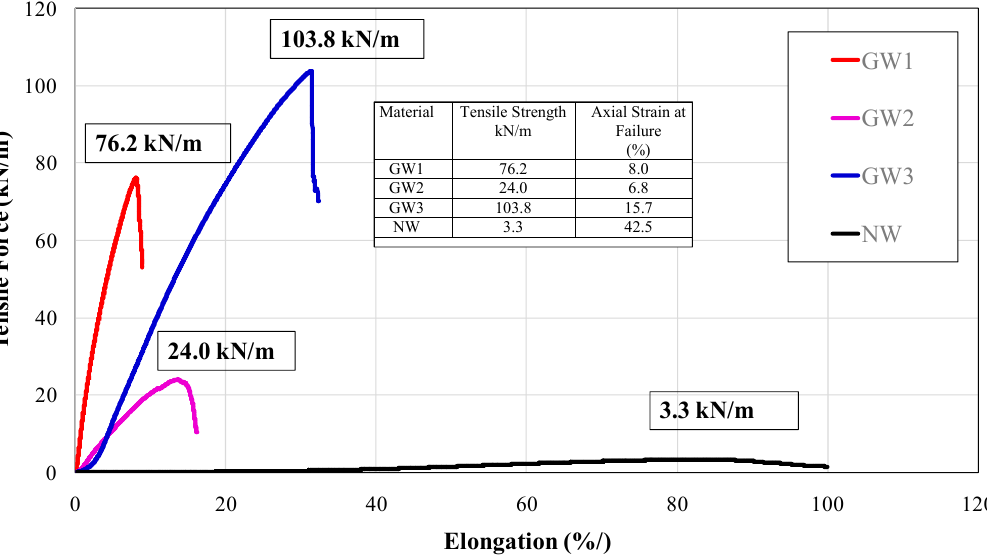
Figure 3. Wide-width strip test on geosynthetics used in the current research.